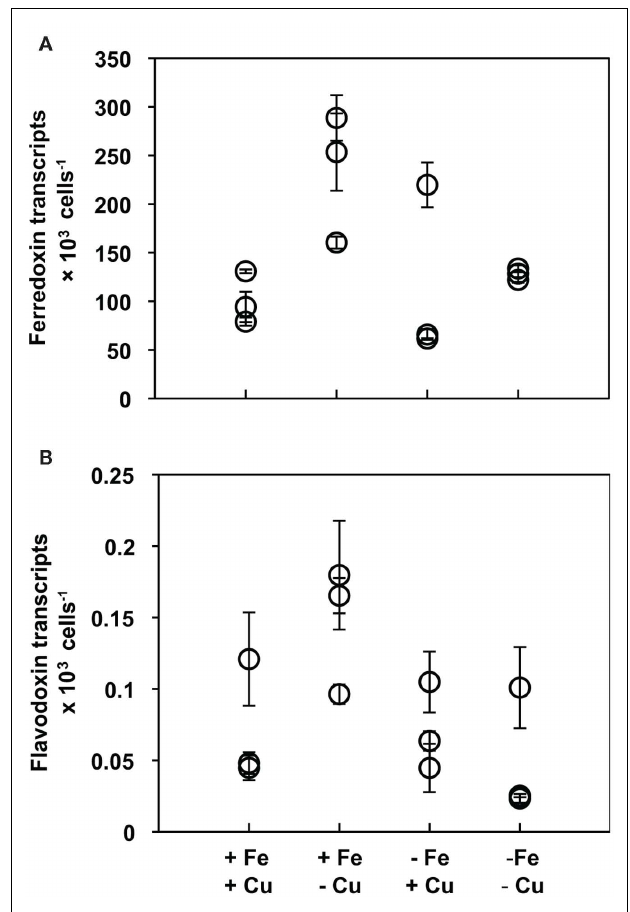
FIGURE 2 | (A) Ferredoxin and (B) flavodoxin transcript abundances normalized to cell number in T. pseudonana cultures acclimated to different culture treatments. Results from culture replicates are shown; each symbol within a treatment indicates a replicate. Error bars represent the SD of triplicate relative transcript abundance determinations (separate cDNA syntheses) for each culture